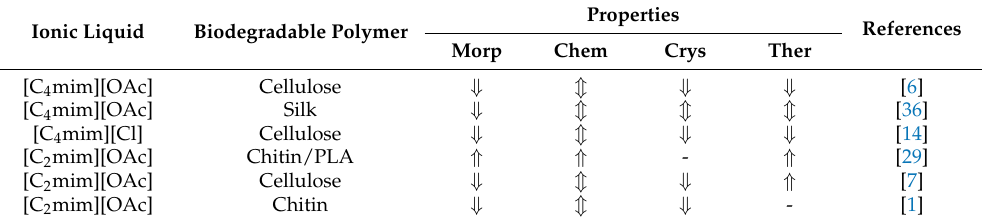
Table 7. Properties of electrospun biodegradable polymer fibers assisted by ionic liquids as solvents.